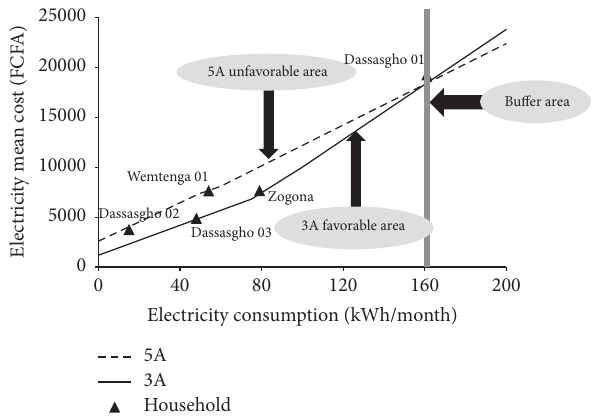
Figure 3: Households consumption according to the calibration of the meters. The cost of the electricity is calculated according to SONABEL tariff grid.